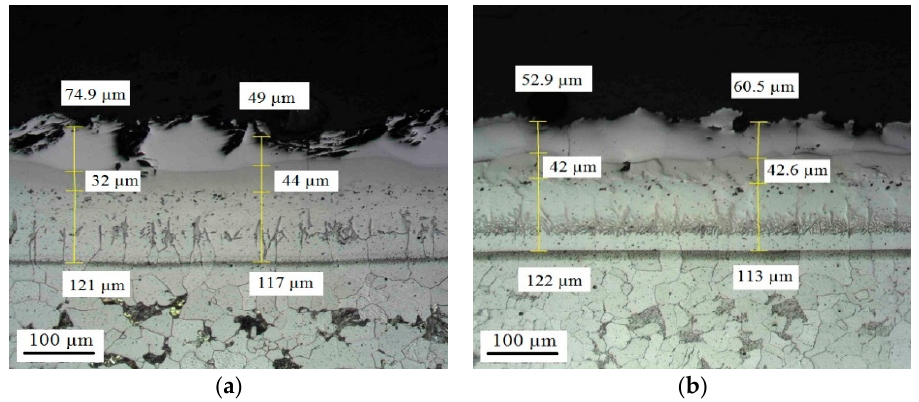
Figure A14. Microscopic images of the cross-section of CS-A ( a ) before and ( b ) after the high-temperature corrosive attack after 168 h.